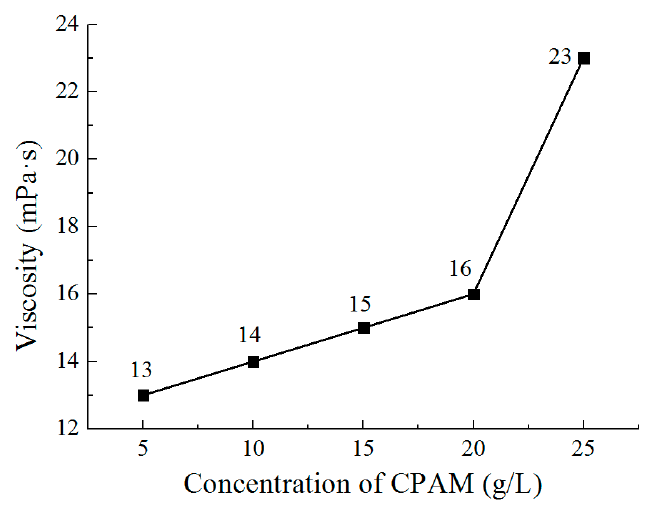
Figure 5. The viscosity of the electrolyte with different concentrations of CPAM.